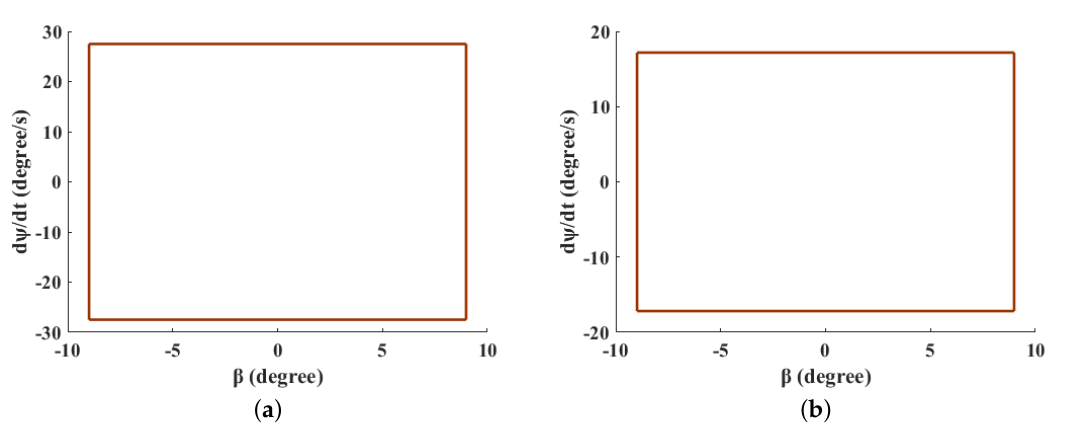
( a ) ( b ) Figure 12. Stability area; ( a ) v x = 50km/h and µ = 0.8; ( b ) v x = 80km/h and µ = 0.8.